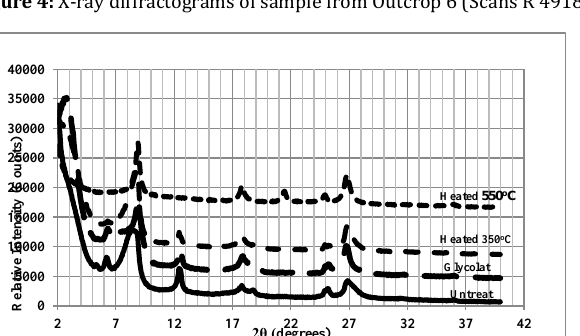
Figure 4: X-ray diffractograms of sample from Outcrop 6 (Scans R 4918)